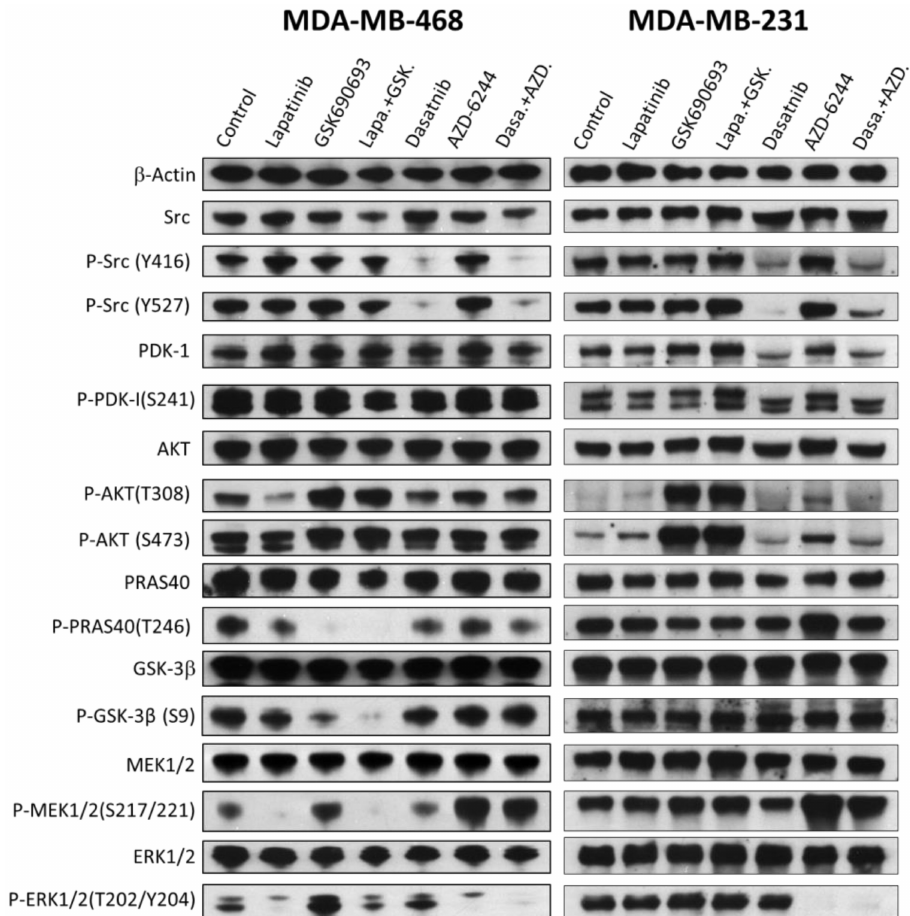
Figure 6. Western blot analyses of the e ff ects of protein kinase inhibitors on the status of key